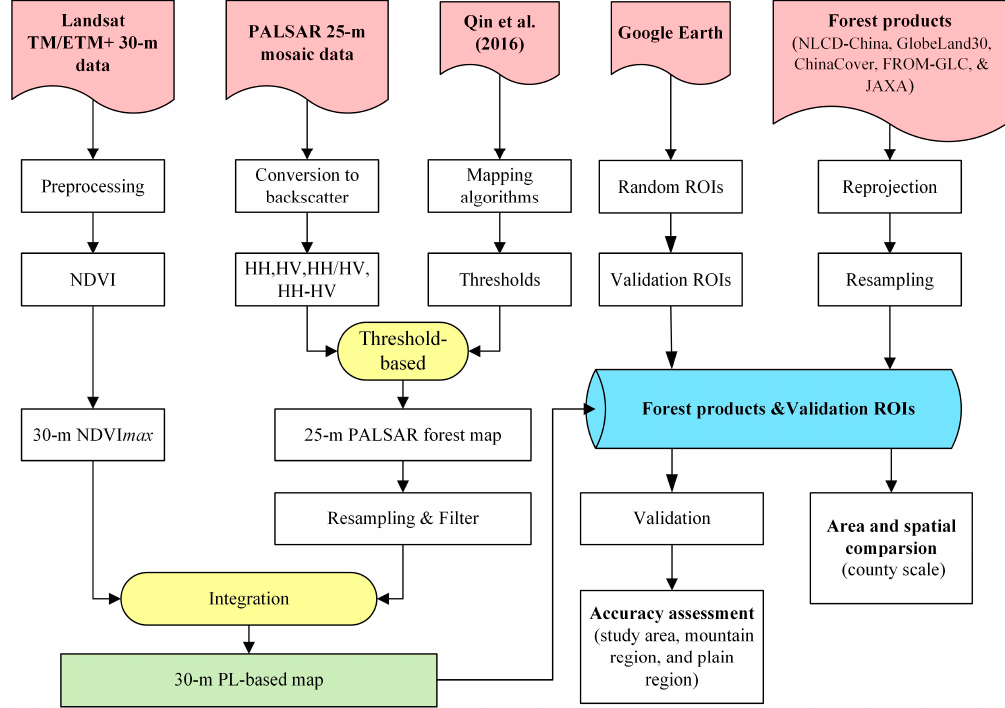
Figure 3. Workflow of forest mapping based on PALSAR and Landsat data in North China Plain.